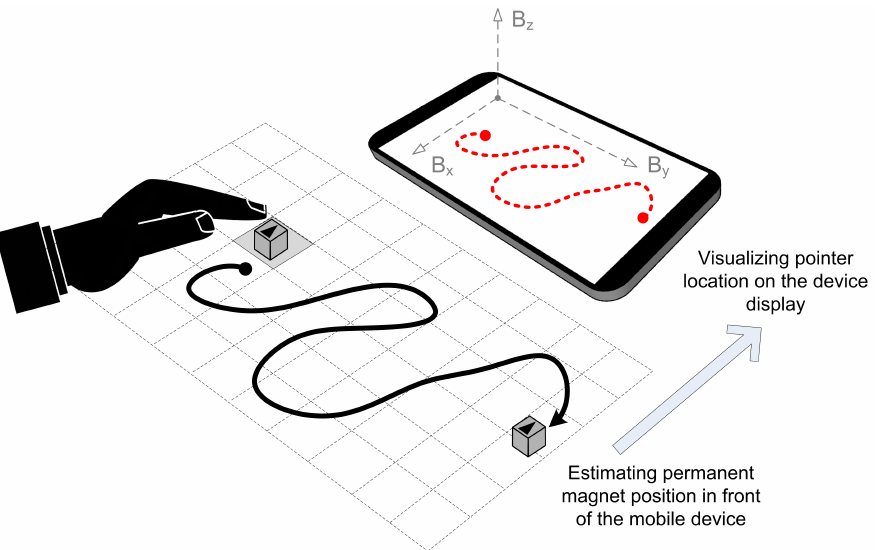
Figure 5. The concept of free-move pointing operation enabled by magnet-based